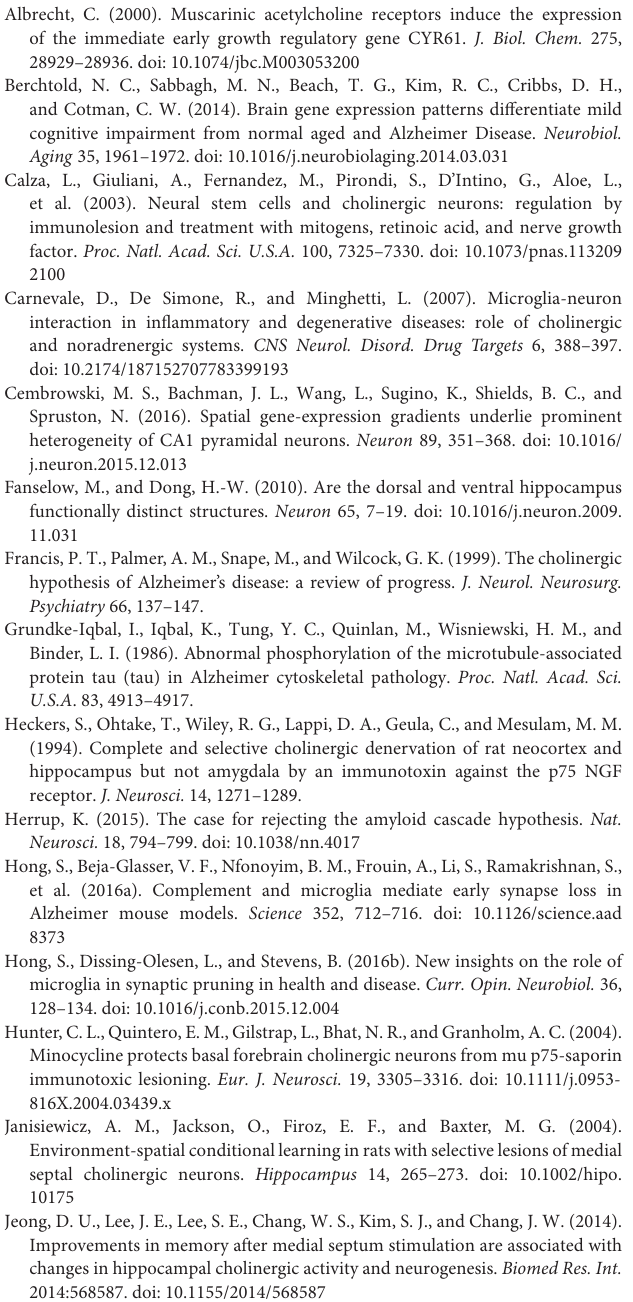
FIGURE S1 | Effect on IgG-saporin on learning in T-maze. Graph shows the time spent in the central arm of the maze. Rats that received IgG-saporin ( n = 8) spent smaller time in the central arm as compared to the saline-treated rats ( n = 8) only during the first trial. Bars represent mean ± SEM. ∗ P < 0.05. FIGURE S2 | Effect of IgG-saporin on passive avoidance learning. Trained IgG-saporin-treated rats ( n = 8) tended to decrease latency to enter the dark chamber compared with trained saline rats ( n = 8). Bars represent the mean ± SEM. ∗ P < 0.05.